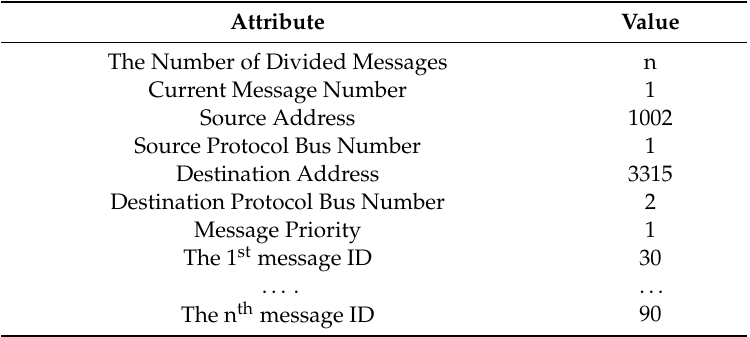
Table 2. Example of the address table (MOST to